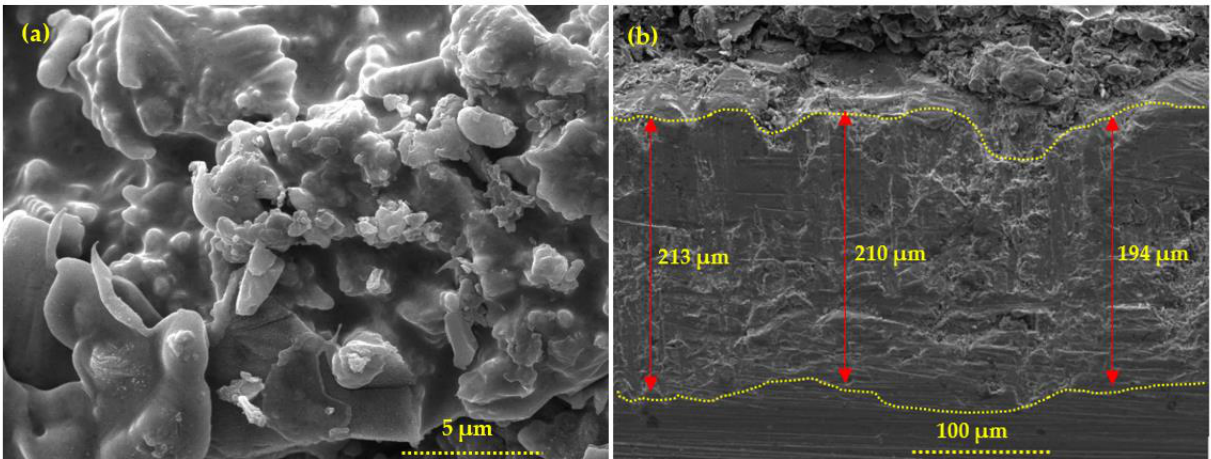
Figure 5. SEM of ( a ) top surface at 10,000 × and ( b ) cross section at 500 × . Table 4. Physical properties of the concrete.